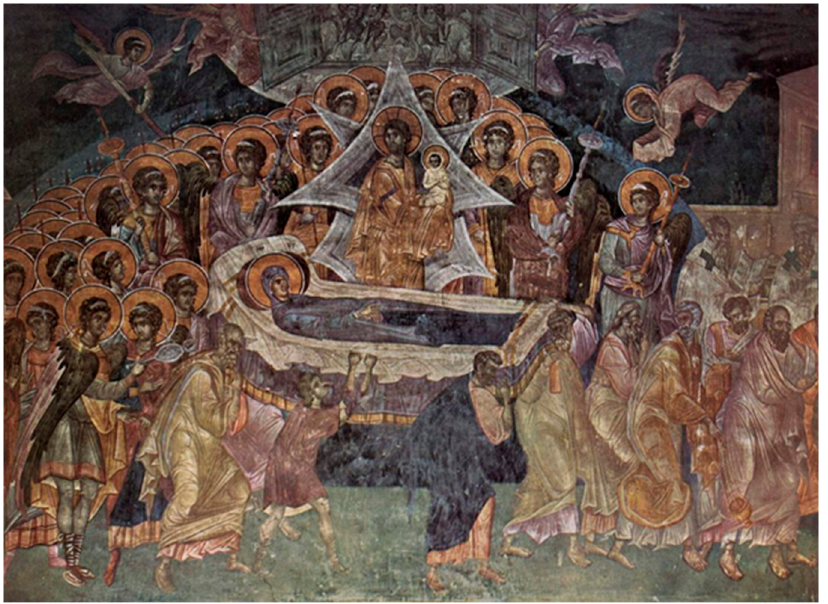
Figure 7. Dormition of the Theotokos , ca. 1321–1322, Church of the Holy Virgin, Gra č anica Monastery, Kosovo. (Photo credit: The Yorck Project ).